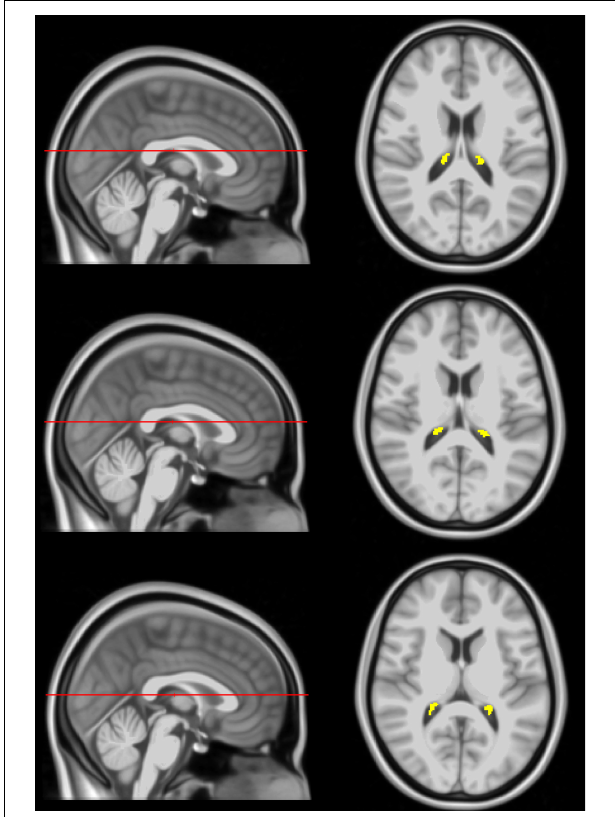
FIGURE 1 | Example of CP ROI location, extracted using FreeSurfer, in the posterior portion of the lateral ventricles projected on the MNI atlas at three different slices. The right side shows an axial view of the segmentation while the left side shows the sagittal view of the slice